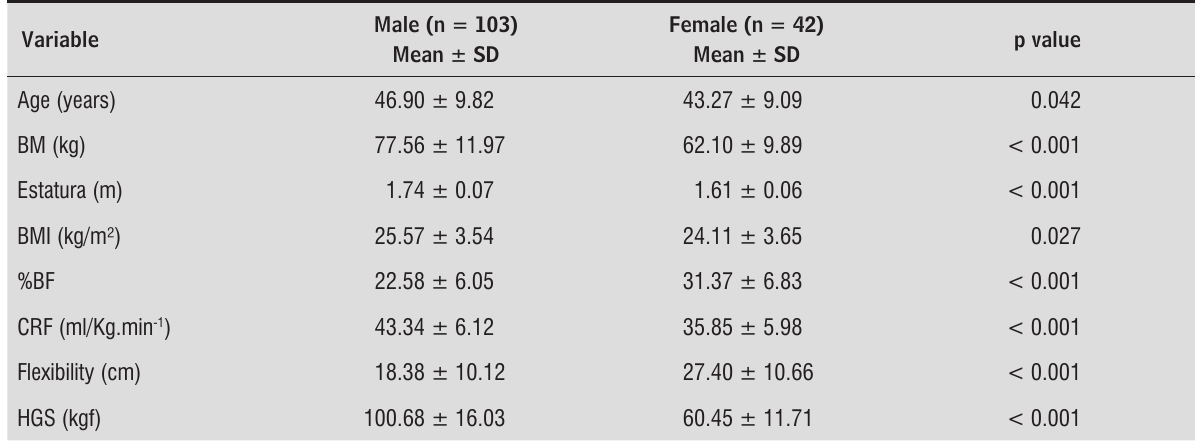
sexes.test Table 1 - Characterization and comparison of the physical fitness and health components of professors at UFV, according to sex